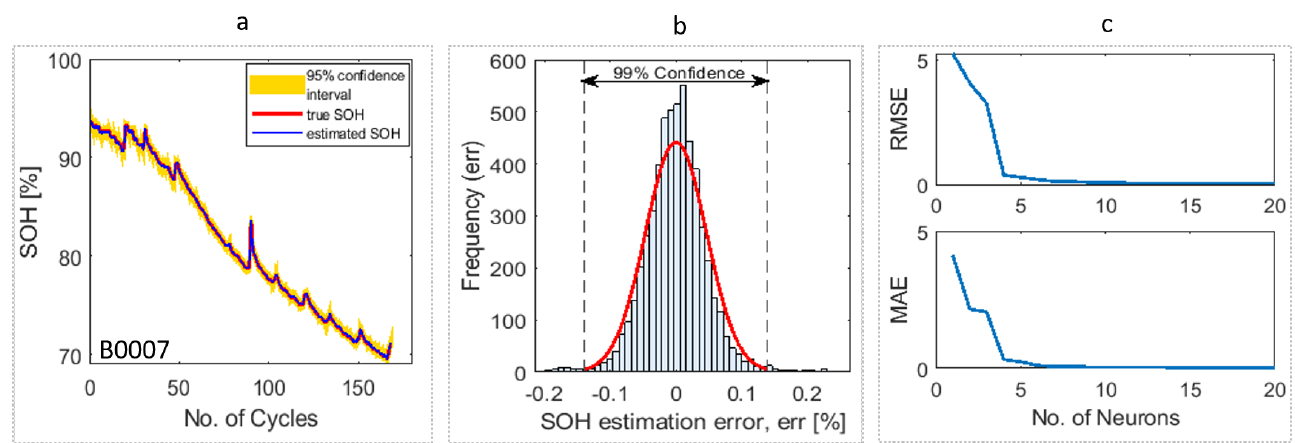
Figure 6. The result of parallel layer extreme learning machine (PL-ELM) model trained with B0007 dataset and consideration of a 99% confidence interval on the error. ( a ) The result of SOH estimation with 20 neurons. ( b ) Normal distribution of the error for 99% confidence interval ( c ) performance versus model complexity over 20